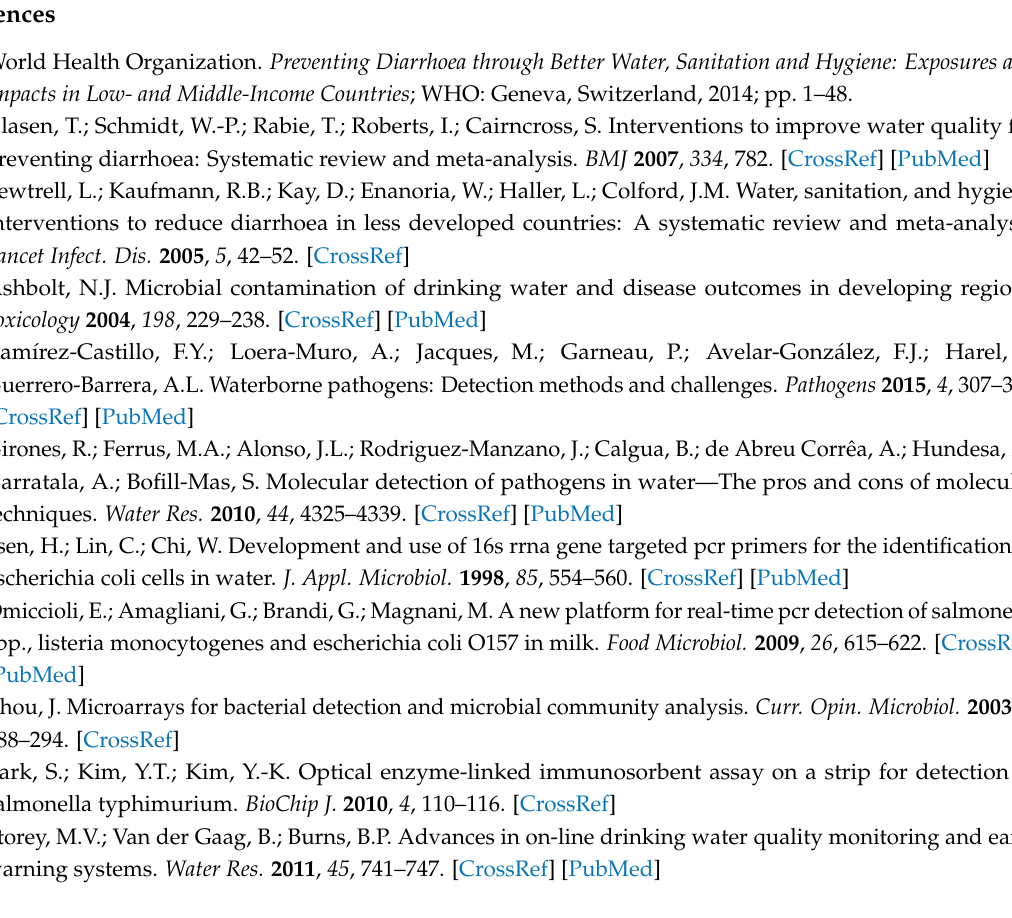
Figure S1. Standard curve evaluating the ability of different lysozyme concentrations ranging from 1 mg/mL to 0.001 mg/mL to lyse bacteria using the BacTiter kit. The amount of viable bacteria decreases as the amount of lysozyme increases as expected. The R 2 value for the regression was 0.9693. Figure S2. Gold nanoparticles change color in the presence of decreasing concentrations of DNA complexes. The image showing the spectrum of gold nanoparticles in the presence of decreasing concentration of DNA complexes. The dark blue tube on the far left has the highest concentration of bacterial DNA combined with the H1 and H2 oligos (concentration: 10 µ M), which is then diluted 10-fold in each adjacent tube while the tube containing no complexes appears red on the far right. Figure S3. Controls for the device prototype. The first tube on the left contains a mixture of tap water and gold nanoparticles and it appears red. The middle tube contains gold nanoparticles with no additional components present, which serve as a negative control. The tube on the right contains E. coli along with the gold nanoparticles and it appears red. Figure S4. Validation of our water quality detection device prototype. The Eppendorf tube containing the DNA probes, lysozyme, and gold nanoparticles with no bacteria present is on the right. The Eppendorf tube containing the DNA probes, lysozyme, and gold nanoparticles with E. coli present (concentration: 10 6 cells/mL) is on the left. The change in color from red to blue is visually